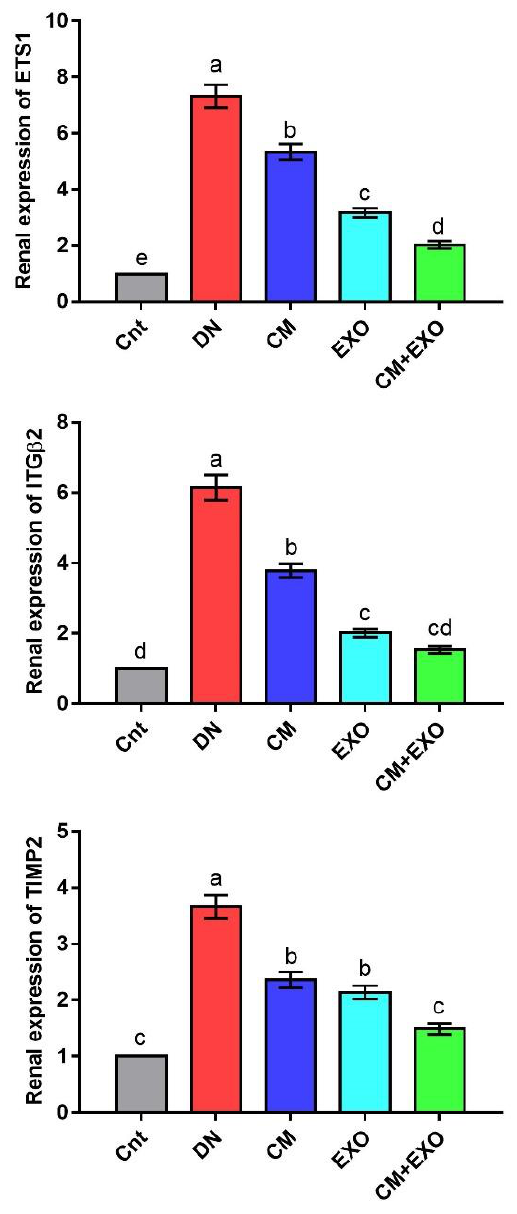
Figure 4. Effect of camel milk and/or its EXOs on renal expression of matrix remodeling genes ( ETS1 , ITG β 2 , and TIMP2 ) as detected by real-time PCR. Values were expressed as fold change mean ± SEM (n = 6/group). Columns carrying different letters (a (the highest value)–e (the lowest value)) are significantly different at p < 0.05. All groups were compared to each other. Each data point represents an average of three independent experiments with three replicates for each. Cnt, control group; DN, diabetic nephropathy group; CM, camel milk-treated group; EXO, camel milk exosomes-treated group; CM + EXO, co-treated group with camel milk and its exosomes.